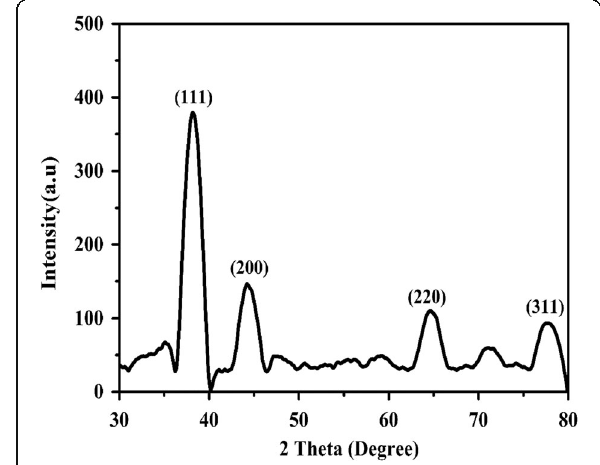
Fig. 4 XRD pattern of papaya leaf extract capped gold